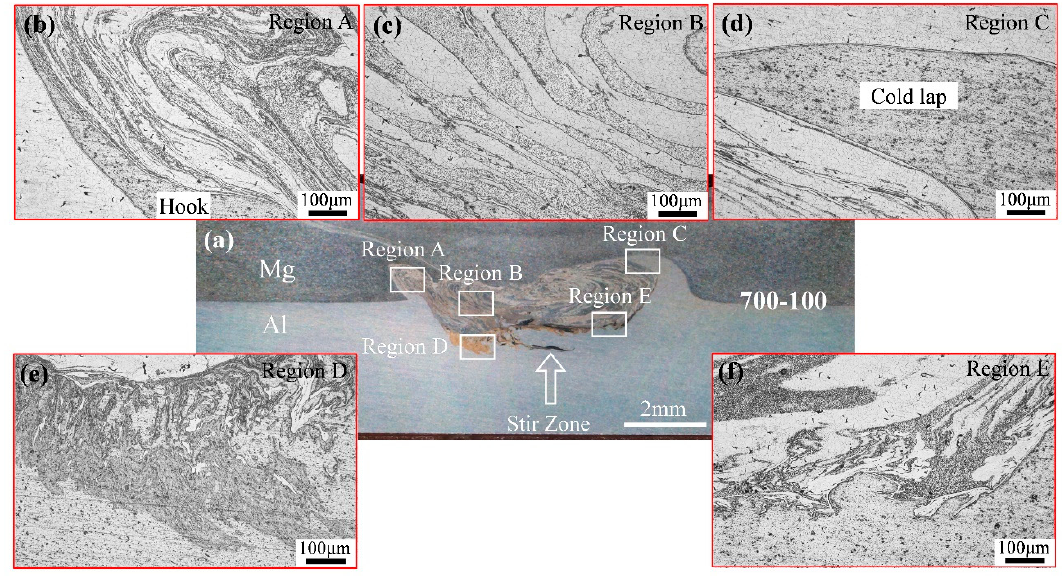
Figure 8. Macrostructure and microstructure of the joint welded in Configuration Mg-Al at 700 rpm: ( a ) macro structure; ( b ) hook; ( c ) SZ; ( d ) cold lap; ( e ) SZ bottom at the AS; ( f ) SZ bottom at the RS.